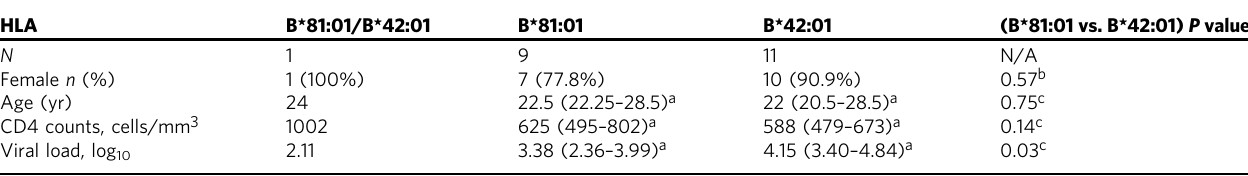
N/A not applicable All values in parenthesis were expressed as interquartile range. Participants with other protective alleles present in the cohort of study were excluded in the study Excluded alleles: HLA-B*57:03; B*58:01; B*39:01